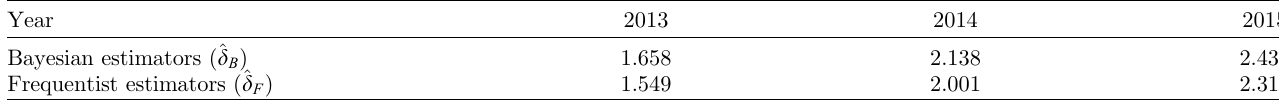
Table 7. Mean of 1000 replicates of equation (13) with m = 1000 each to the left (a), and to the right (b) its standard deviation. Year Mean (a) Standard deviation